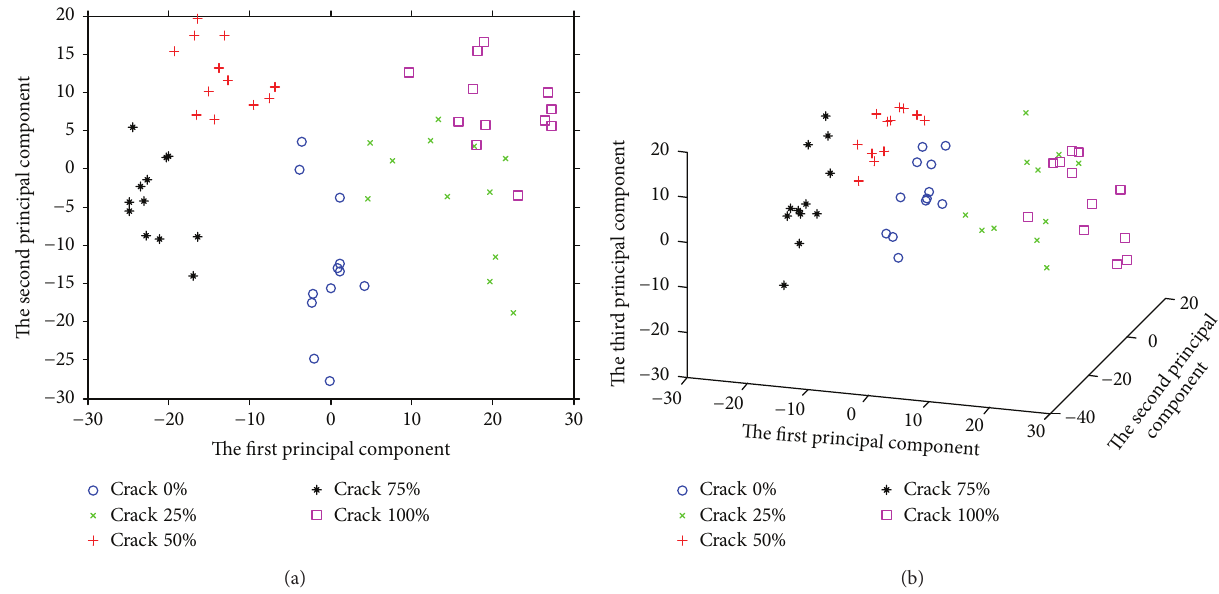
Figure 6: The principal components of the training data for experiment 1 : (a) the first two principal components; (b) the first three principal components.